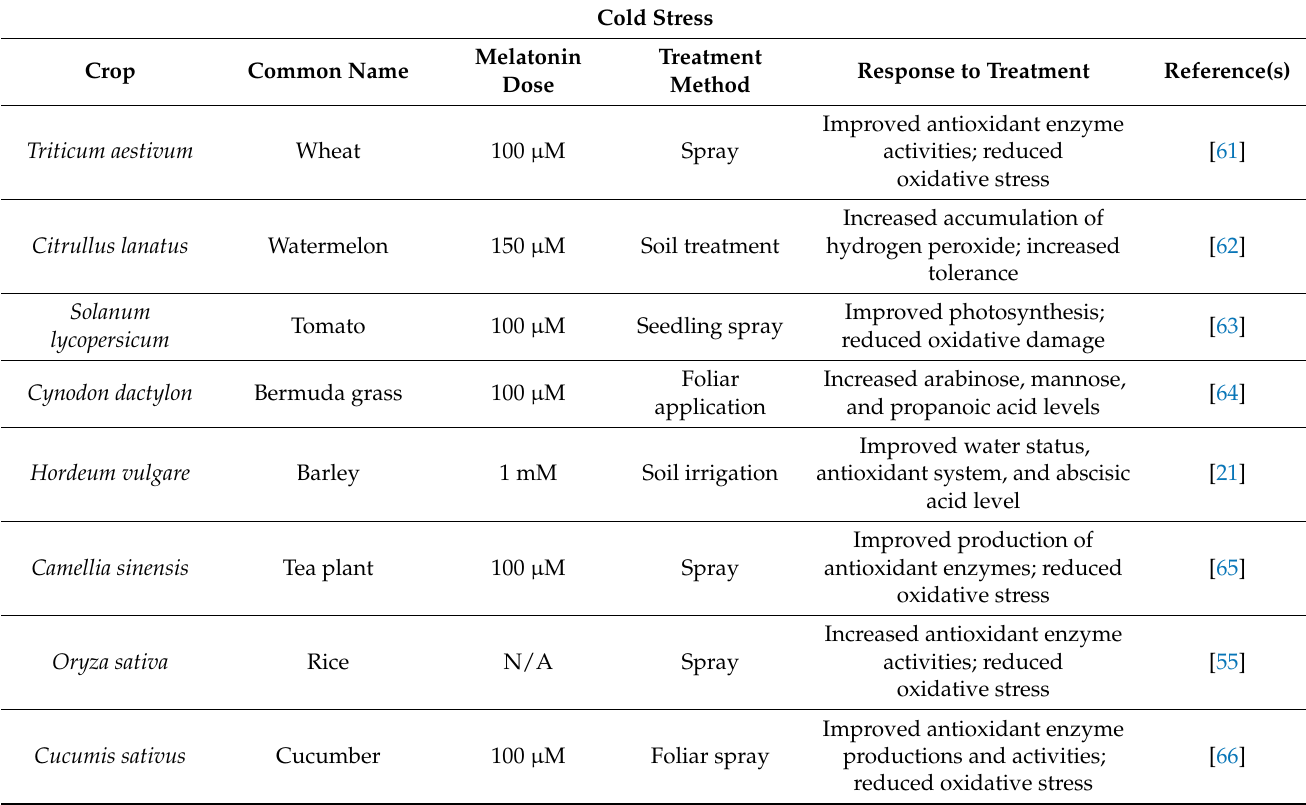
Table 4. Physiological responses of various crops to melatonin treatment against cold